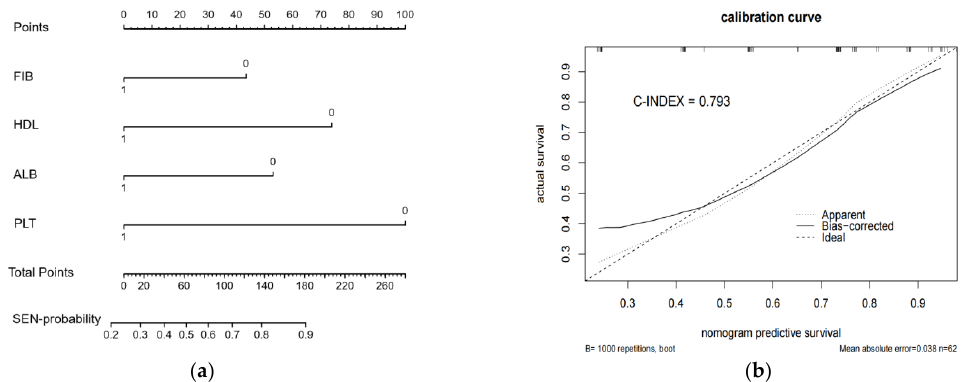
Figure 3. Nomogram ( a ) and calibration curve ( b ) of the blood model to predict IC response in ad- vanced LSCC. The four blood indicators were categorical variables, where ≥ cutoff value is 1 and < cutoff value is 0.